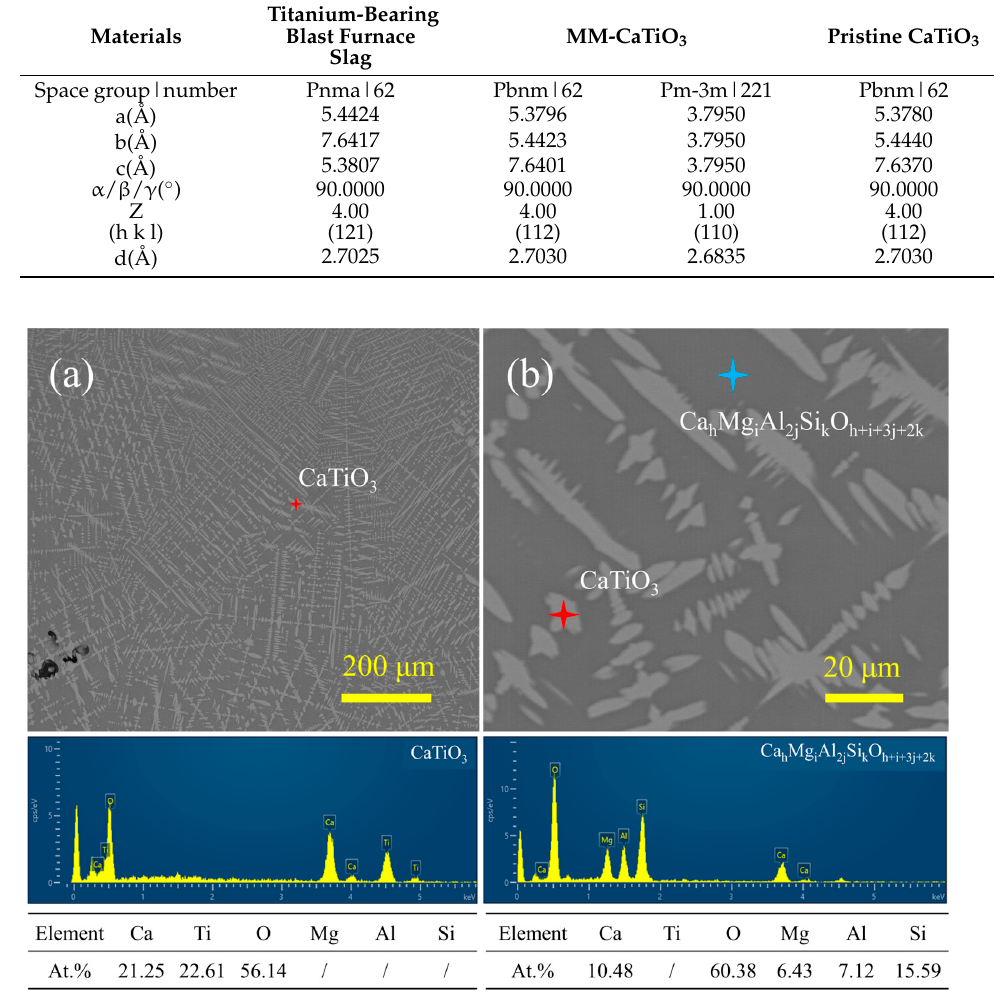
Table 1. The lattice parameters of CaTiO 3 in various materials.